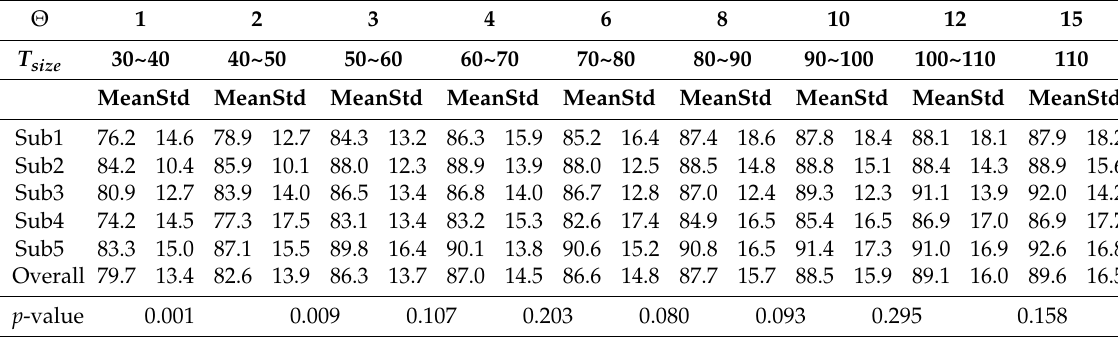
Table 6. Recognition accuracies (%) of 110 CSL sign words at different sizes of training set (Sub5 as reference subject).